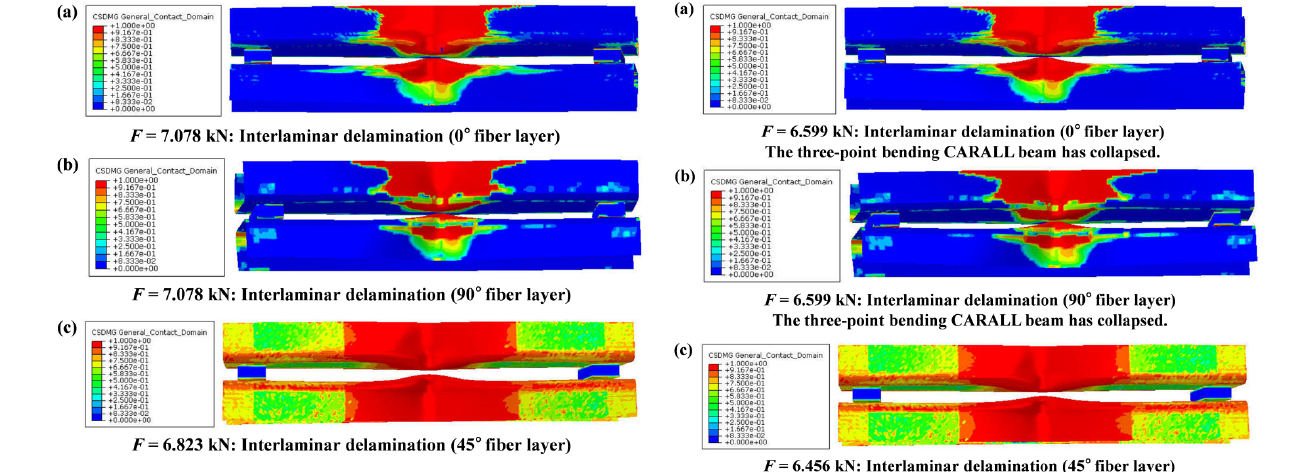
Figure 13: Delamination failure area distribution of double-channel CARALL beams in ultimate bearing state: (a) SHCXL-A: 0 ∘ fiber layer; (b) SHCXL-A: 90 ∘ fiber layer; and (c) SHCXL-B: 45 ∘ fiber layer. layer and the adjacent layers of the SHCXL-B beam was